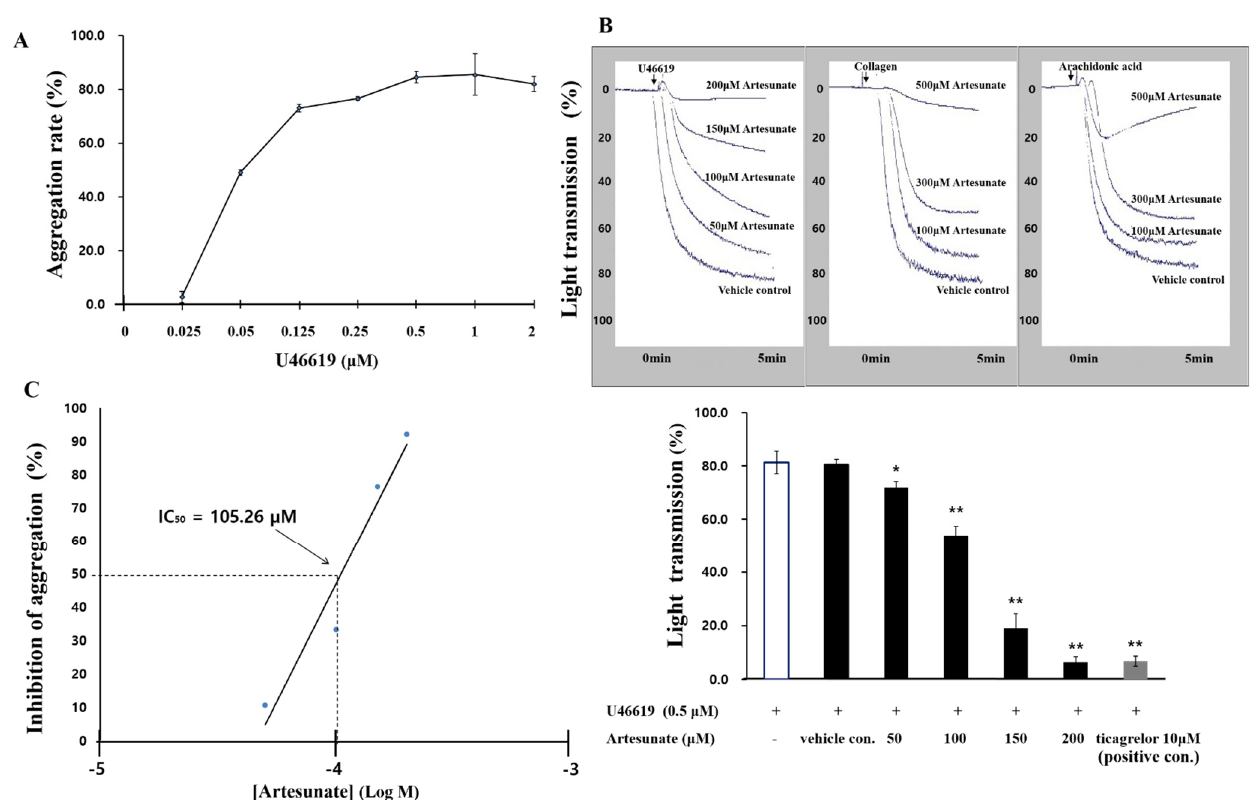
Figure 1. Artesunate’s effect on platelet aggregation induced by U46619. ( A ) The U46619 threshold dose on human platelet aggregation. ( B ) Artesunate’s effect on platelet aggregation. ( C ) IC 50 value of artesunate on platelet aggregation induced from U46619. The results are shown as mean ± SD ( n = 4). * p < 0.05, ** p < 0.001 in comparison to the U46619 − induced vehicle control.